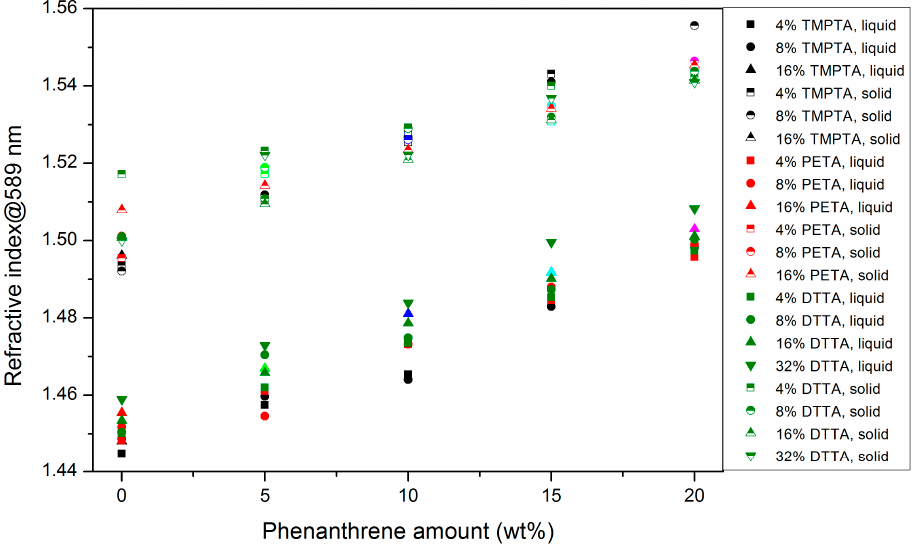
Figure 6. Refractive indices of all investigated mixtures prior (liquid) and after curing (solid).